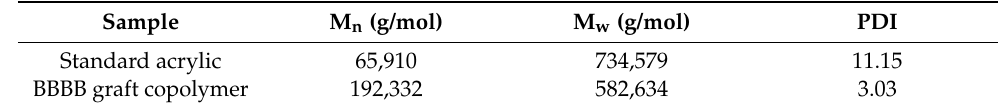
Table 3. Number average molecular weight, weight average molecular weight, and polydispersity index of the standard acrylic polymer and BBgraft polymer with BPS.